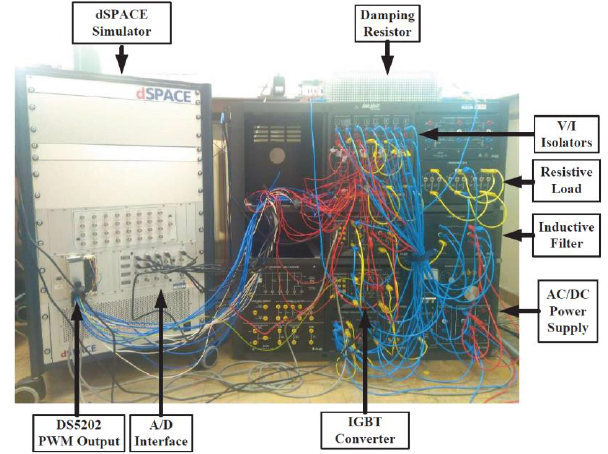
Figure 5. The experimental platform based on the dSPACE platform.